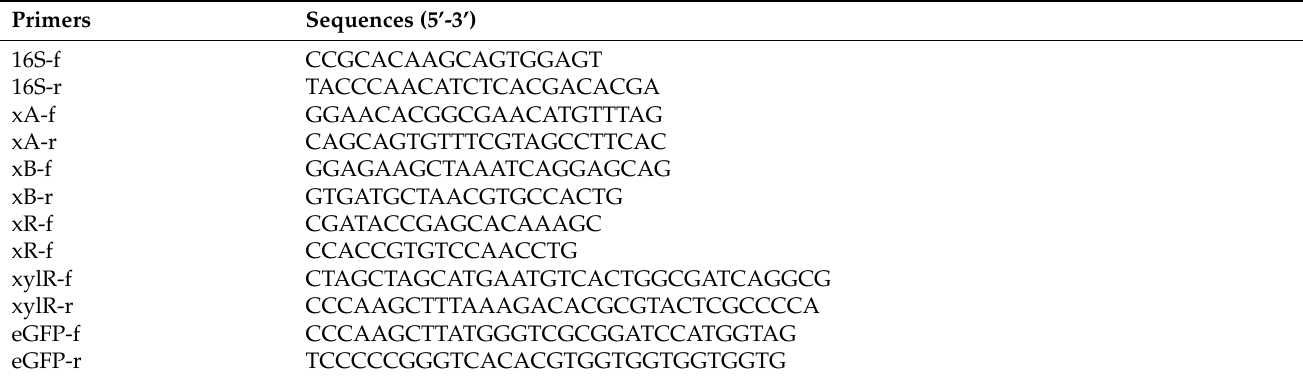
Table 1. Primers used to obtain fragments or construct